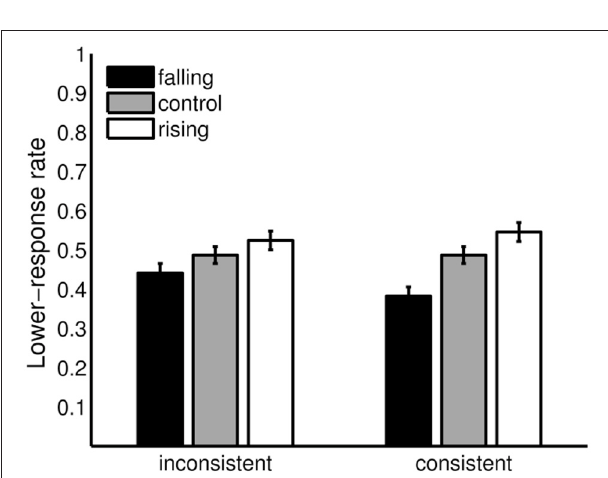
FIGURE 7 | Aftereffects in the consistent and the inconsistent condition. Lower -response rates in the inconsistent (envelope centers of the adaptor sequence and tritone pairs A 3 – C 6 and C 6 – A 3 ) and the consistent condition (envelope centers of the adaptor sequence and tritone pairs A 3 – A 3 and C 6 – C 6 ) for the falling and rising adaptor sequence in comparison with the control condition. Error bars represents the standard error of mean ( n =